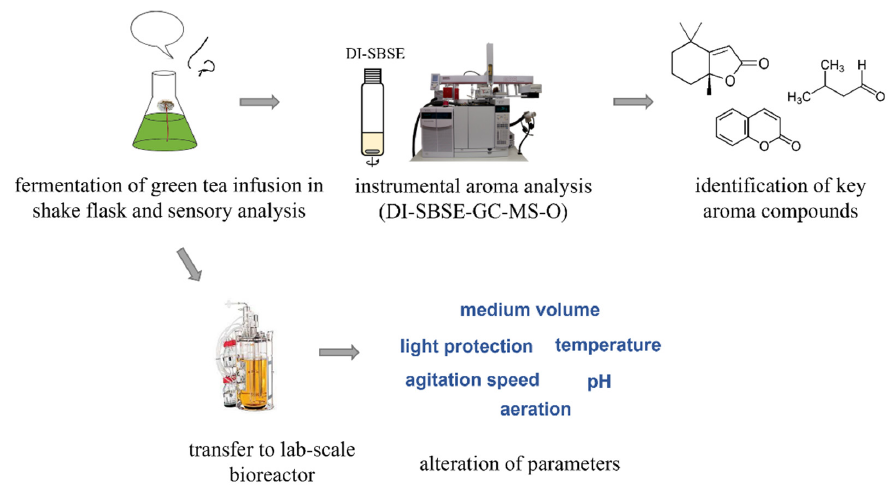
Figure 1. Schematic representation of the study.